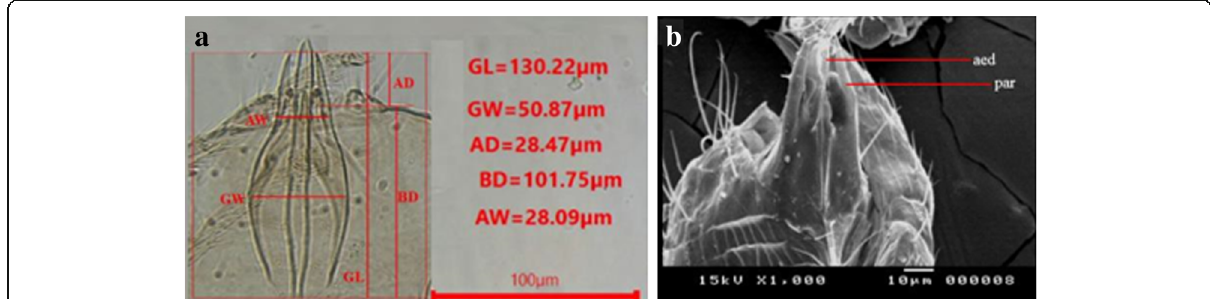
Fig. 9 Male genitalia: a light micrograph of TNV male genitalia with measurements in μ m and b SEM of TNV male genitalia with setae and hairs